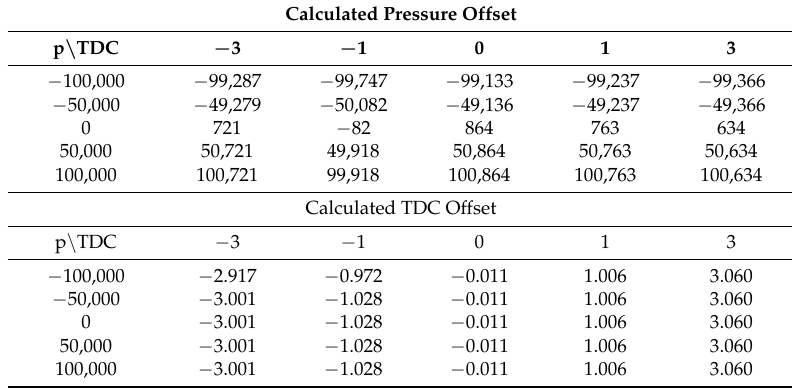
Table 9. Calculated pressure and TDC offsets and their absolute errors for the MAN engine and operating point 2400 1/min and 373 Nm using the off-line